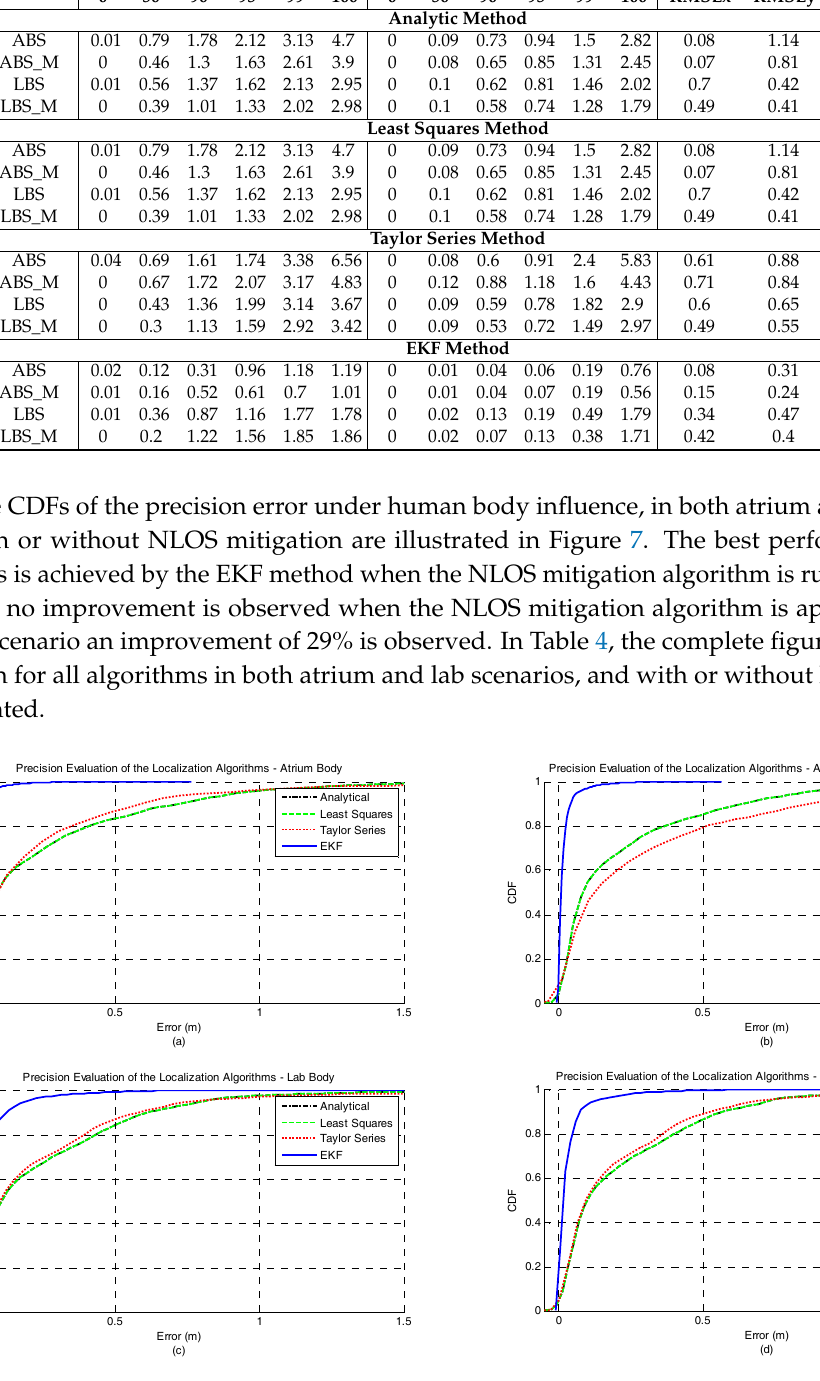
Figure 7. Comparison of the precision achieved by each algorithm for static nodes with human body interference and with or without NLOS mitigation. The first row represents the precision achieved by each algorithm in atrium with ( a ) and without ( b ) NLOS mitigation. Whereas, the second row represents the precision achieved by each algorithm in lab with ( c ) and without ( d ) NLOS mitigation.